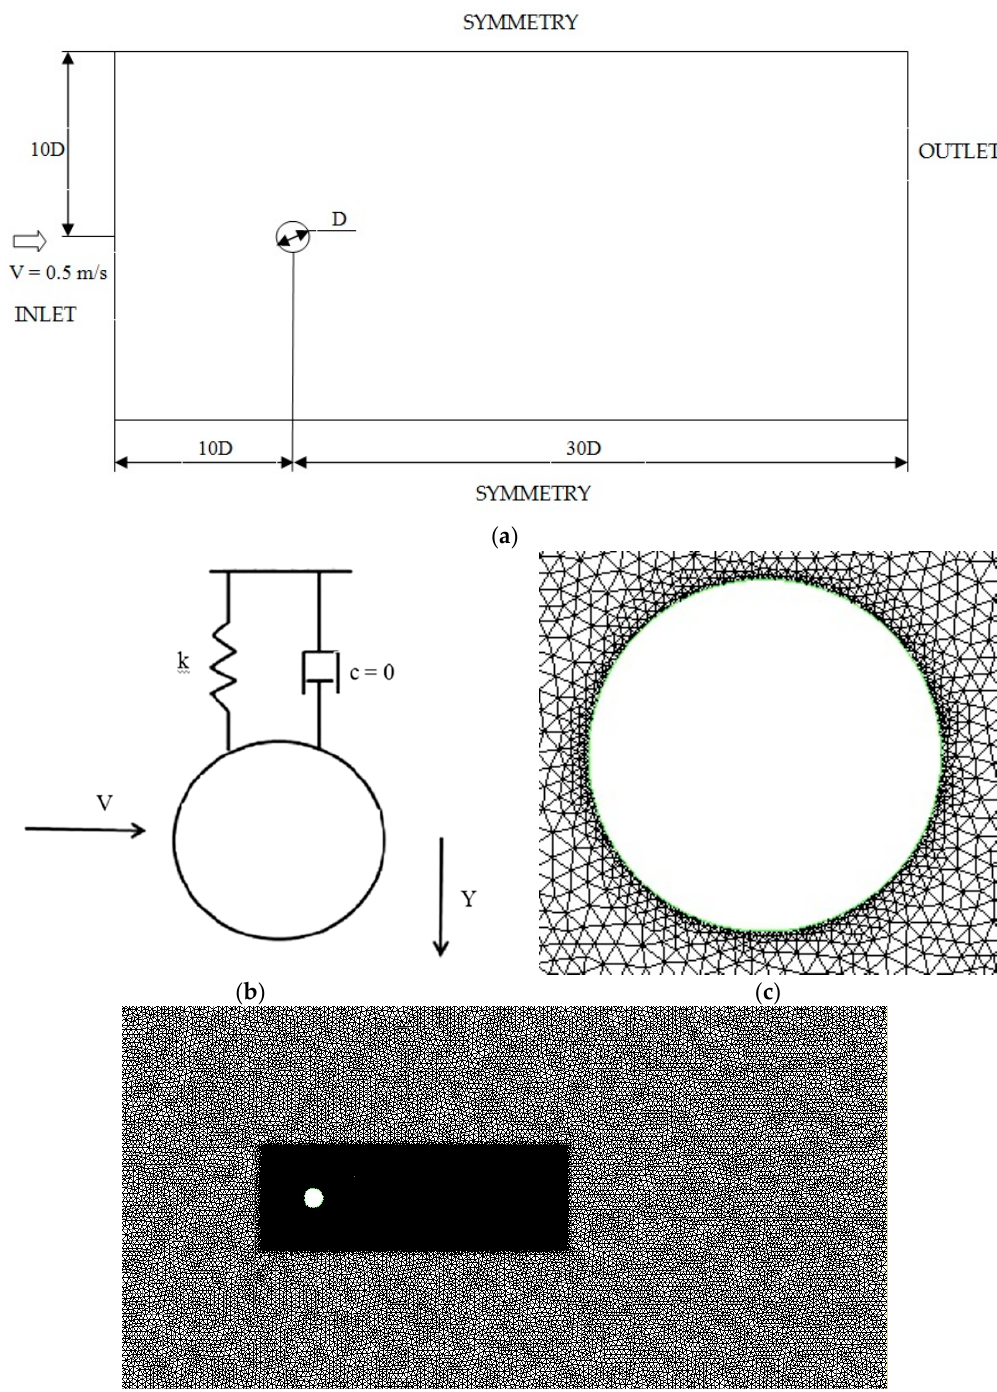
Figure 3. ( a ) Computational domain; ( b ) representation of elastically mounted cylinder model; ( c ) mesh around the cylinder; ( d ) computational mesh.